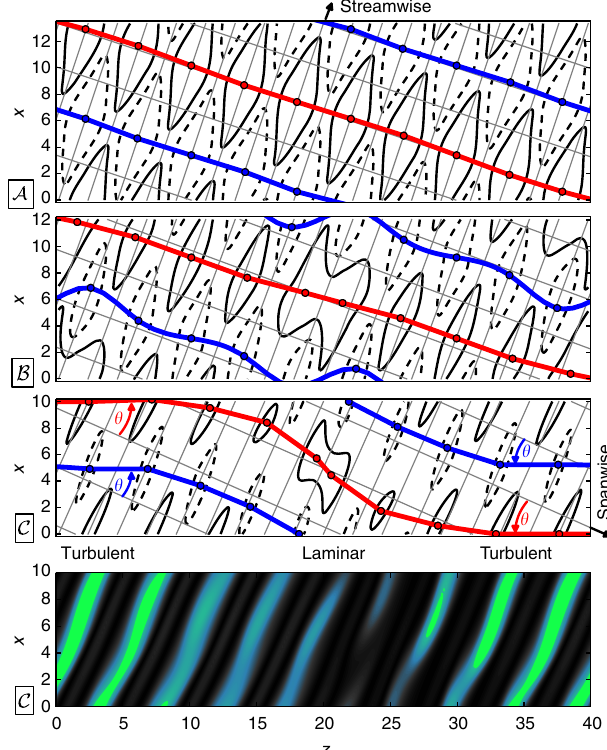
Fig. 4 Pattern forming bifurcations give rise to the stripe equilibrium.